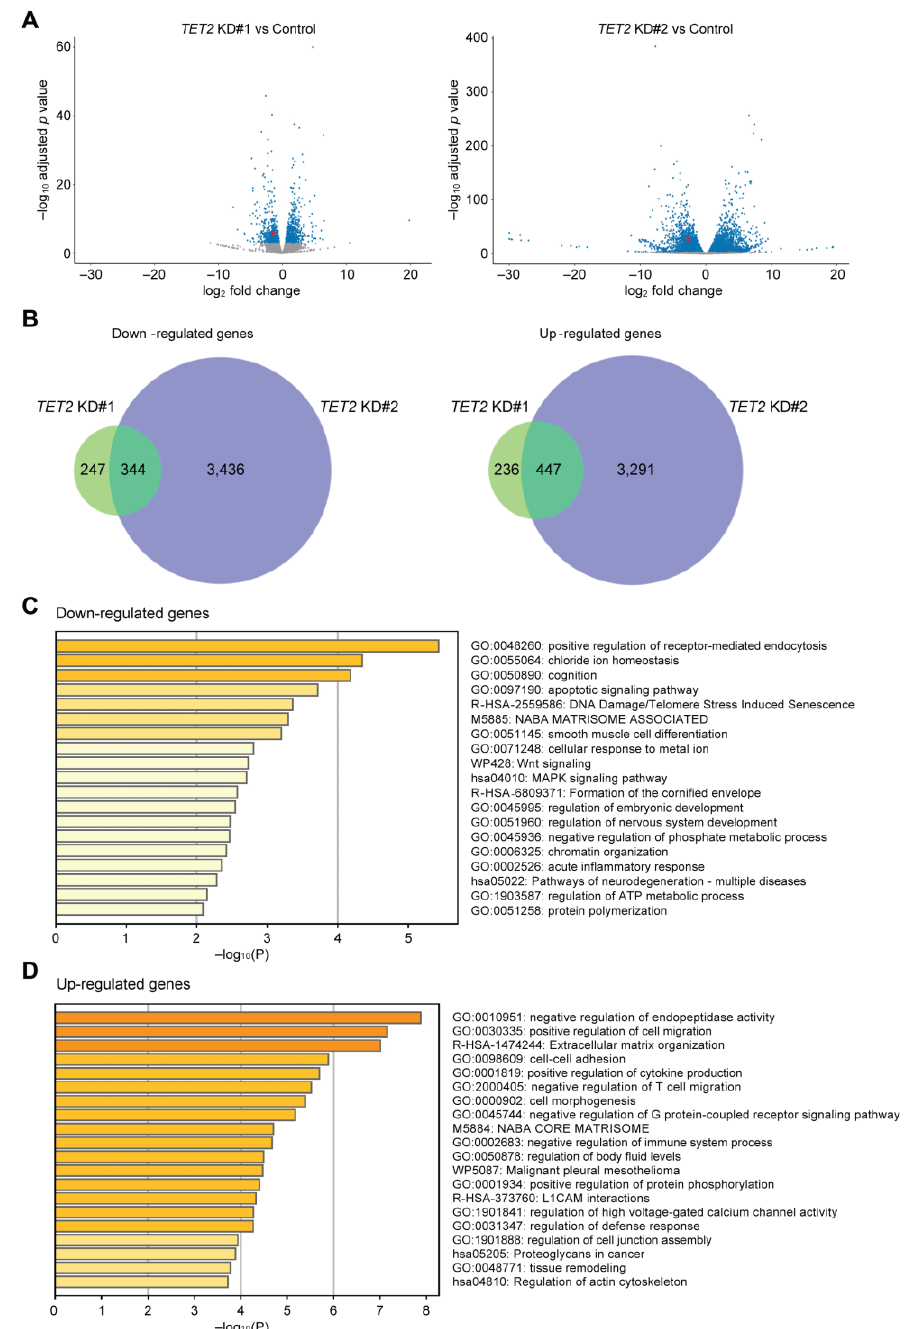
Figure 3. Characterization of TET2-regulated pathways in corneal epithelial cells. ( A ) Volcano plots depicting mRNA expression levels in TET2 KD#1 ( left ) and TET2 KD#2 ( right ) cultures. Blue dots represent differentially expressed genes (DEGs) selected as described in the methods. TET2 expression is depicted with red dots. ( B ) Venn diagrams of the overlapping downregulated genes ( left ) and upregulated genes ( right ) in TET2 KD#1 and TET2 KD#2 cultures. Metascape enrichment analysis of the downregulated ( C ) and upregulated ( D ) DEGs shared by both TET2 KD#1 and TET2 KD#2 cultures. All experiments were repeated n = 3 times.